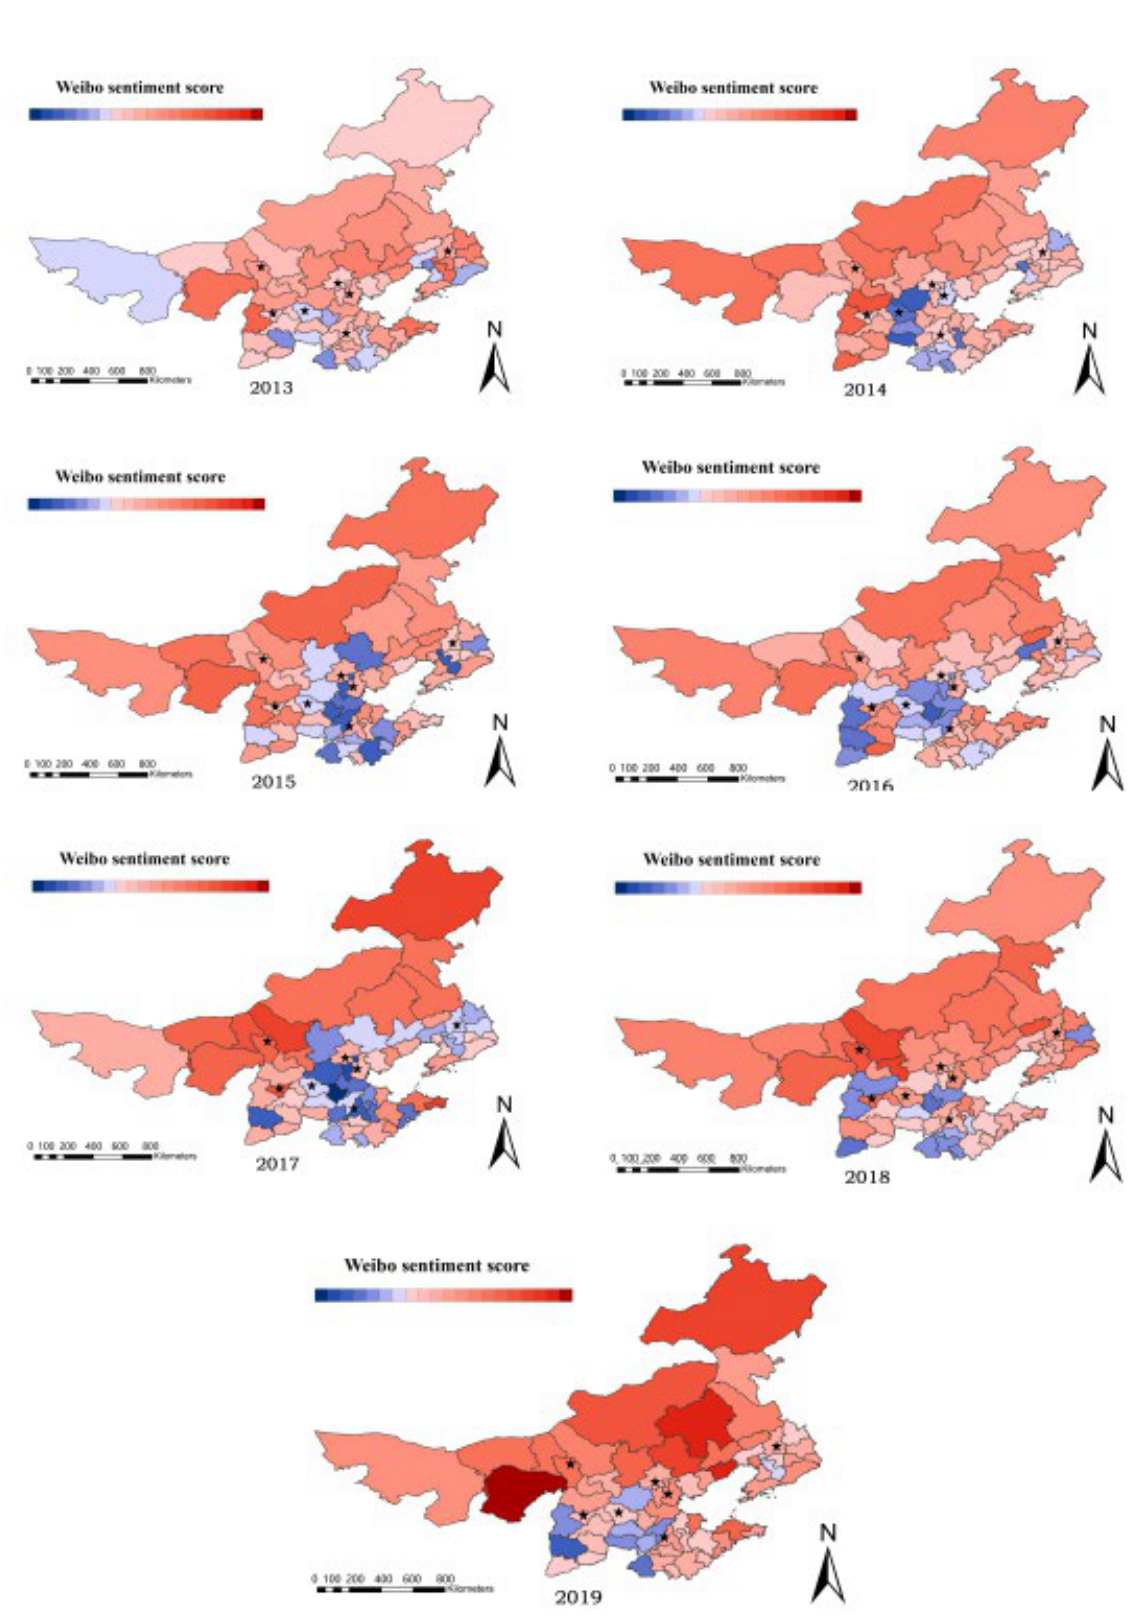
Figure 3. The temporal and spatial dispersion of the sentiment score (red (+); blue ( − )). (The stars indicate the capitals of seven provinces).